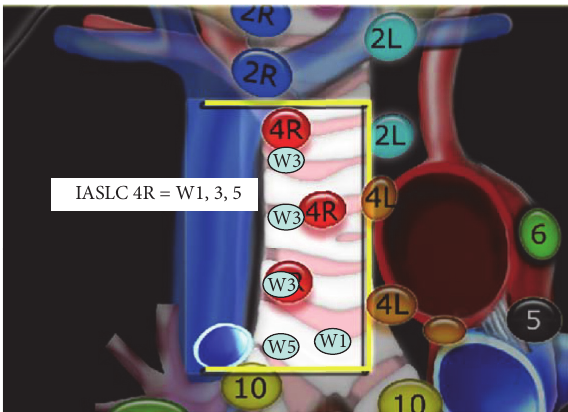
Figure 2: Correlation between IASLC and Wang LN MAP; IASLC 4R: right lower paratracheal LN; W1: anterior carinal LN; W3: right paratracheal LN; W5: right main bronchus LN.